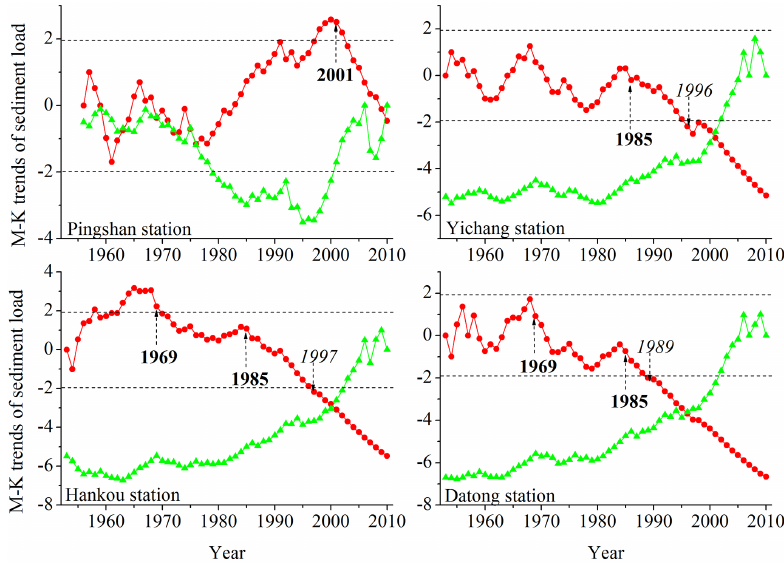
Figure 5. M–K trends of the sediment load for different gauging stations of the Changjiang main river. The red bullets and green triangles denote C 1 and C 2 , respectively. The bold represents the beginning time of sediment load decreasing, and the years in italics denote the time when the M–K trends of the sediment load pass the 95% confidence